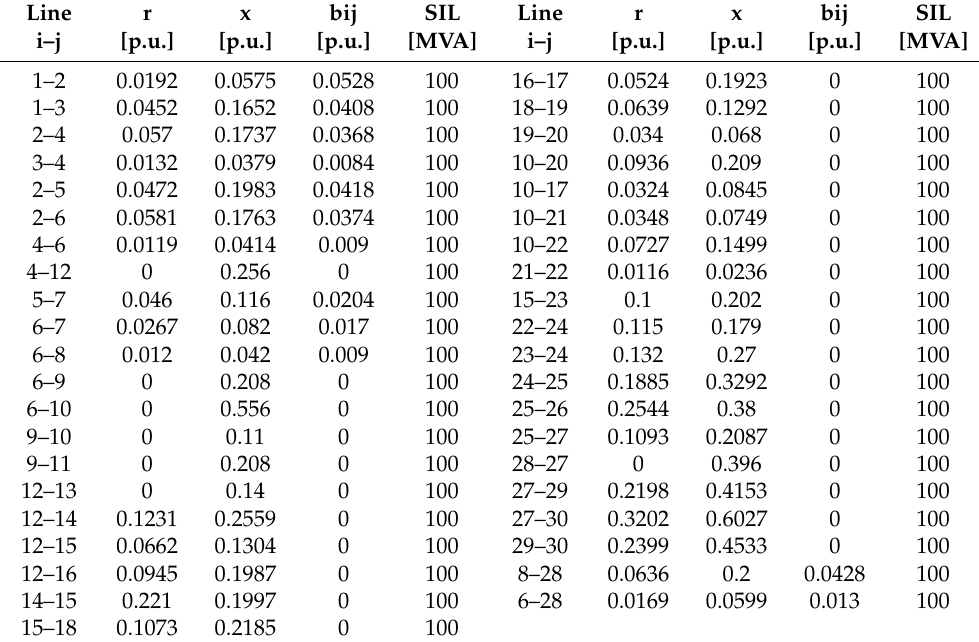
Table 1. 30 bus bar system lines data.